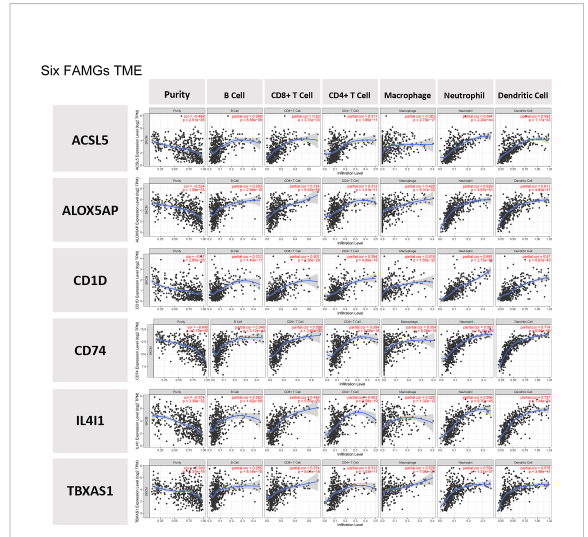
FIGURE 8 TME. The expression levels of the 6 FAMGs expression were positively correlated with the in fi ltration of B cells, CD8 + T cells, CD4 + T cells, macrophages, neutrophils, and dendritic